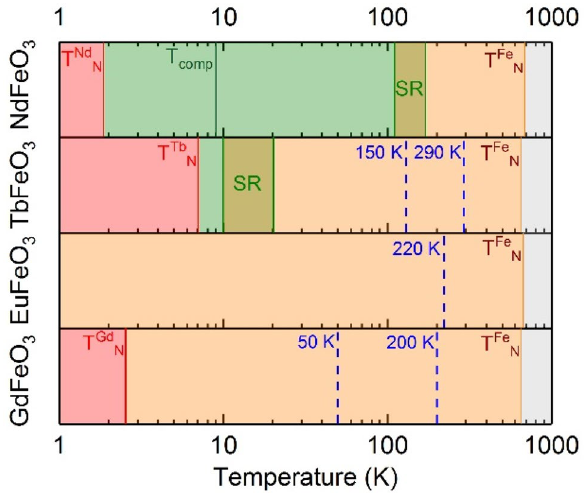
Figure 2. Magnetic phase sequence for R FeO 3 with R = Nd, Tb, Eu and Gd. Critical temperatures of the reported phase transitions taken from Refs. 10,13,25 . Dashed lines mark relevant anomalies observed in this work on M(T) curves, not associated with phase transitions.